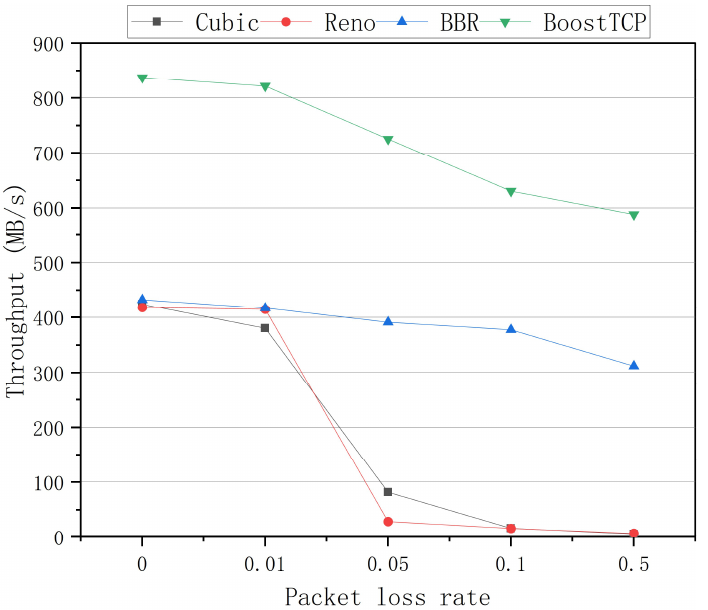
Figure 7. The throughput curves of the four congestion control algorithms as a function of the packet loss rate at a network delay of 50 ms.